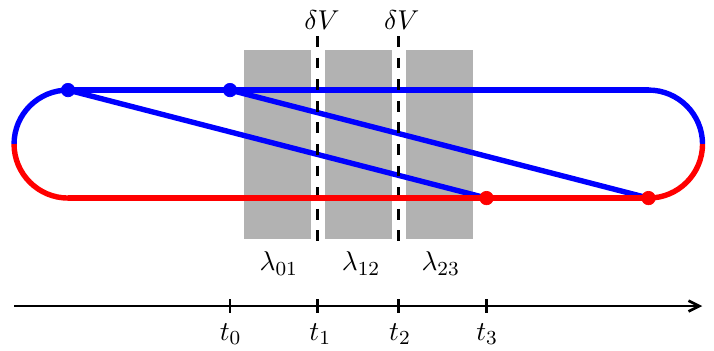
Figure 9 . A depiction of the 2nd-order perturbative correction (3.9) in 1 /N to 4-particle evolution. The shading shows regions of 4-particle propagation where N = ∞ propagators are used. The dashed lines represent insertions of the 1 /N correction δV to the potential at intermediate times t 1 and t 2 , which are integrated